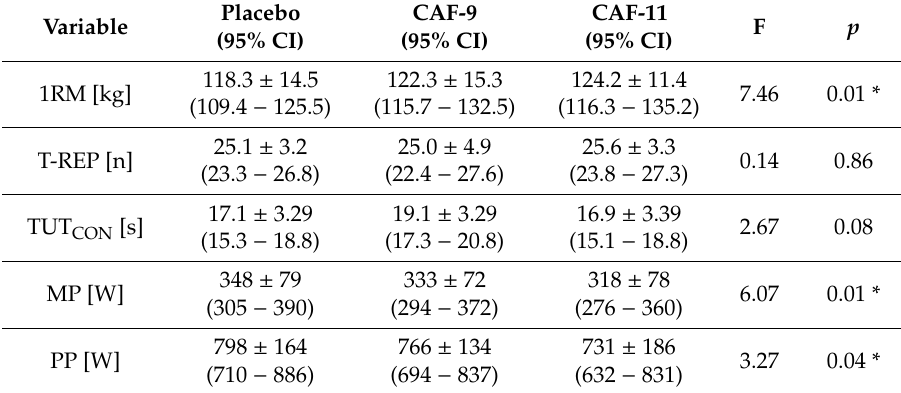
Table 1. Summary of performance data under the three employed conditions.